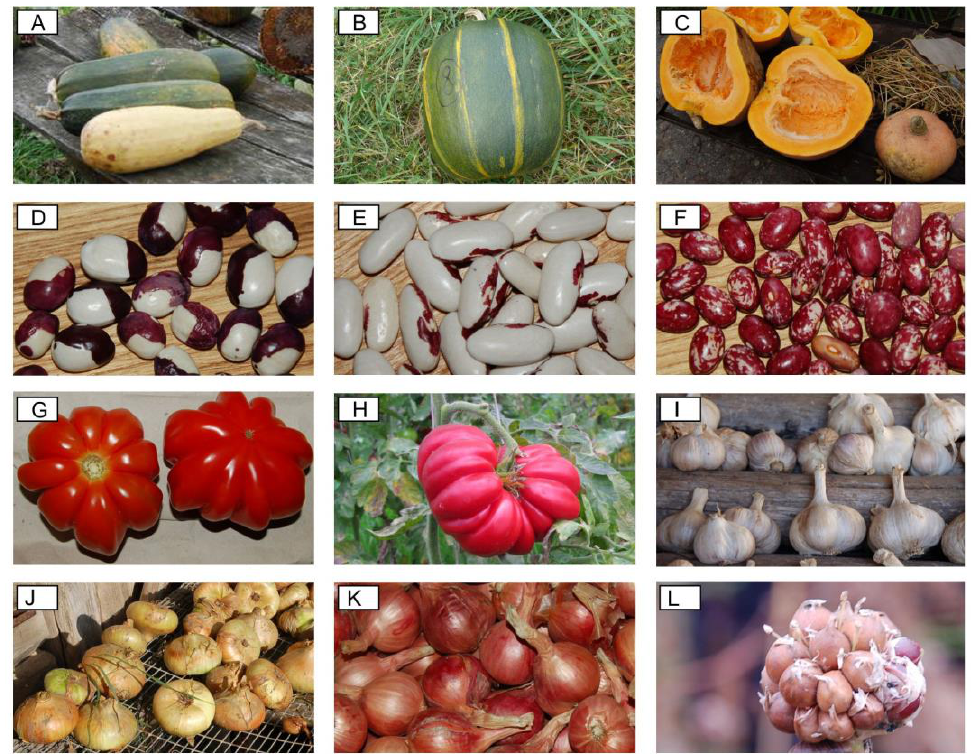
Figure 3. Examples of vegetables collected in Lithuania during the expedition in 2012. Vegetables belonging to the Cucurbitaceae ( A – C ), Fabaceae ( D – F ), Solanaceae ( G , H ) and Alliaceae families ( I – L